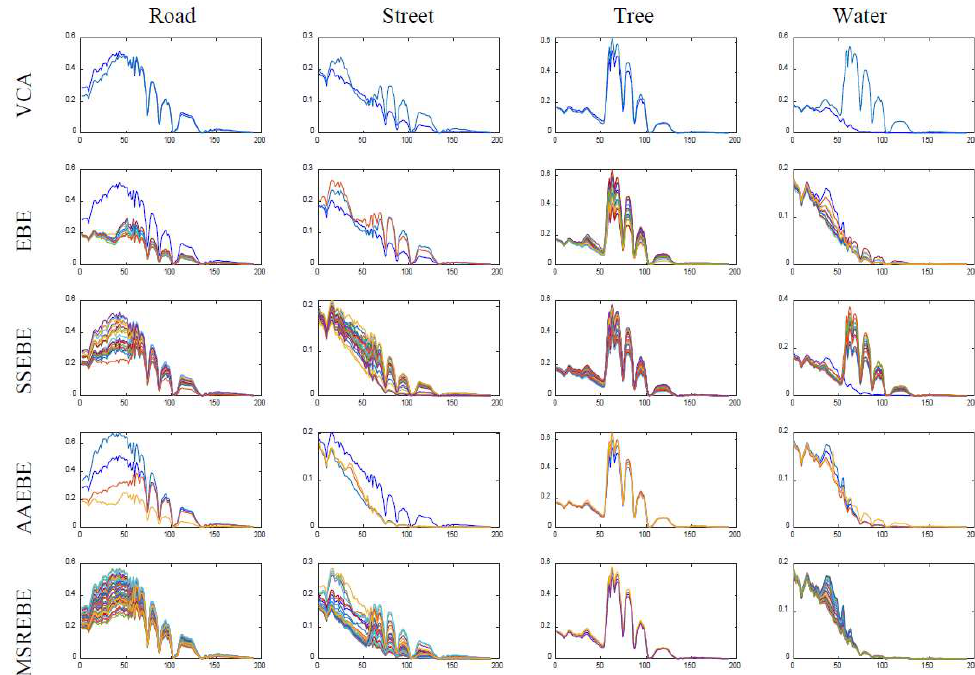
Figure 15. The endmember extraction results of Washington DC Mall dataset.